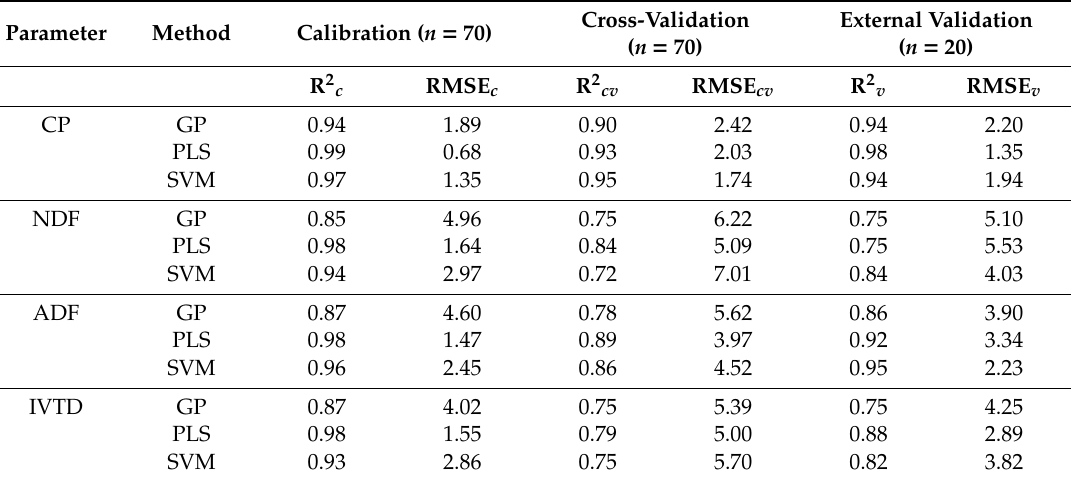
Table 3. Calibration, cross-validation, and external validation statistics obtained for crude protein (CP), neutral detergent fiber (NDF), acid detergent fiber (ADF), and in vitro true digestibility (IVTD) in tepary bean using three calibration